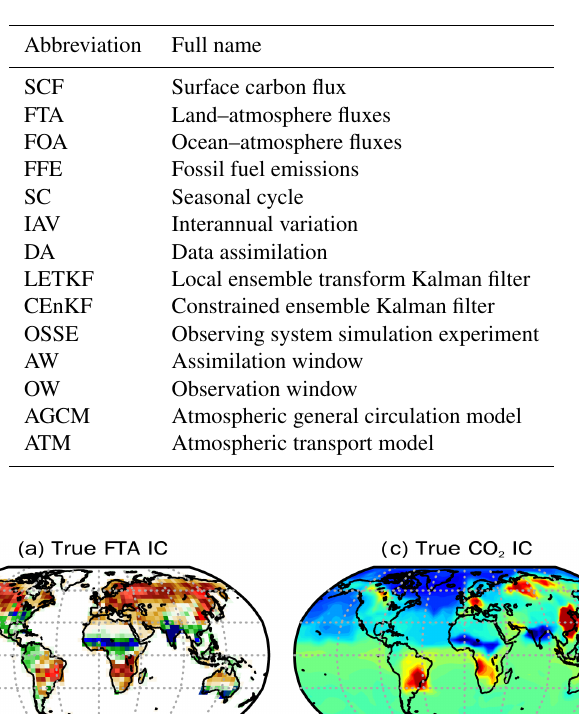
Table A2. List of the major abbreviations and their corresponding full names.